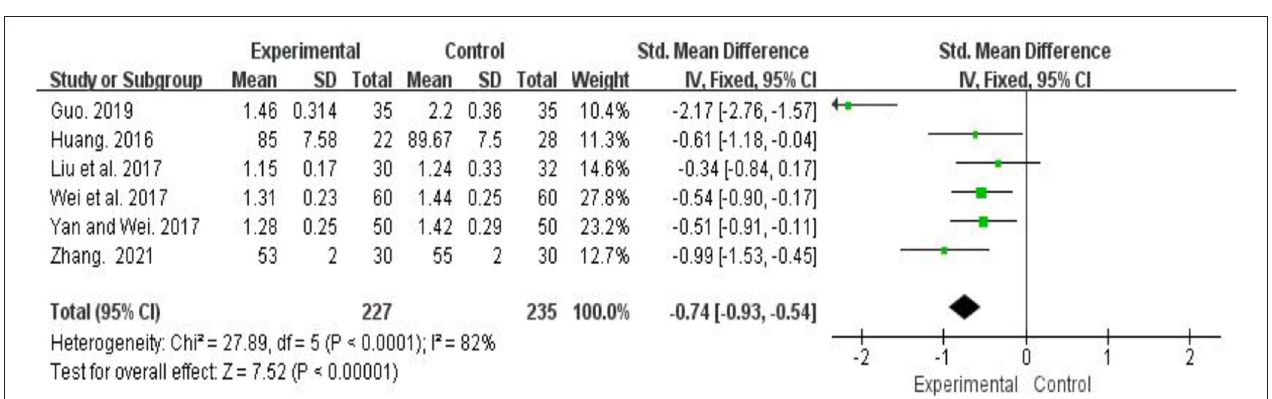
FIGURE 3 | Meta-analysis of traditional fitness exercises on depression (A) among college students. CI, condence intervals; IV, inverse variance. Forest plot for subgroup analysis base on single intervention time (B) . Forest plot for subgroup analysis base on intervention frequency (C) , intervention duration (D) , psychological health level (E) . Forest plot for subgroup analysis base on scale type (F) .